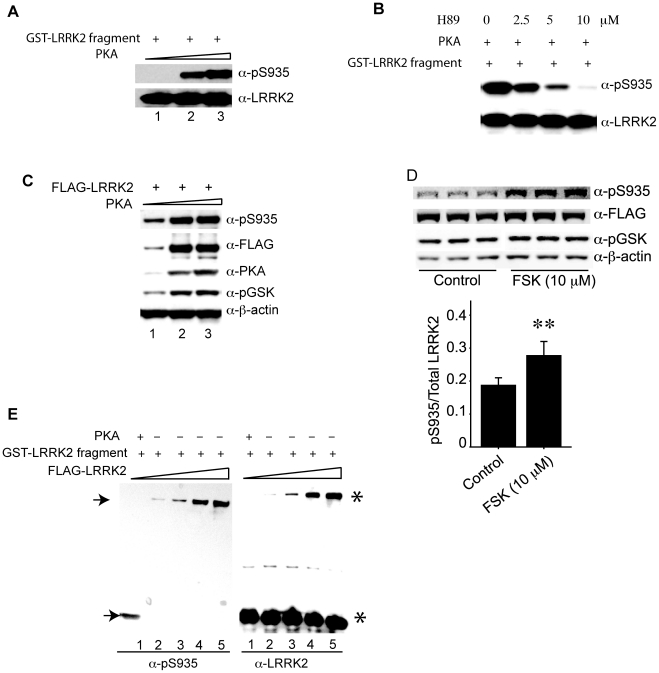
PKA, not LRRK2 itself, can phosphorylate S935 in vitro and within cells.(A) 0.4 µg of purified GST-LRRK2 fragments (800–1000aa) was incubated with different amount of the PKA catalytic subunit (lane 1: without PKA; lane 2: 2500 units PKA; lane 3: 10,000 units PKA). The reaction was stopped by adding 3× SDS-PAGE sample buffer and Western blot was performed by using anti-pS935 and anti-LRRK2 antibodies. (B) Different concentrations of H-89 (0, 2.5, 5 and 10 µM) were added to the PKA and GST-LRRK2 fragment reaction mixture, and Western blot analyses was performed by using anti-pS935 and anti-LRRK2 antibodies. (C) FLAG-LRRK2 was co-transfected with different amounts of PKA plasmid into HEK-293T cells (The ratio of FLAG-LRRK2 verse PKA plasmid DNA are: 0 in lane 1, 1∶1 in lane 2 and 1∶10 in lane 3). The transfected cell lysate was harvested and analyzed by Western blot using anti-pS935, anti-FLAG, anti-PKA, anti-pGSK and anti-β-actin antibodies. (D) FLAG-LRRK2 was transfected into HEK-293T cells and after 40 hours transfection, 10 µM FSK was added to the cell culture medium and incubated for 30 min. Then the cells were harvested and western blot analysis was performed to study various protein levels by using anti-pS935, anti-FLAG, anti-pGSK and anti-β-actin antibodies. The pS935 LRRK2 and total LRRK2 signals were quantified by using the LI-COR Odyssey software system and the ratio of pS935 and total LRRK2 was calculated and analyzed by One-way ANOVA (** P<0.01). Western blot results of three independent experiments are shown, and data are presented as mean value (± SEM) from three independent experiments. (E) GST-LRRK2 fragment (800–1000aa) protein was incubated with purified FLAG-LRRK2 (from mouse brains) or with PKA catalytic enzyme subunit (as positive control) (lane 1: 2500 units PKA; lane 2: 12.5 nM FLAG-LRRK2; lane 3: 25 nM FLAG-LRRK2; lane 4: 125 nM FLAG-LRRK2; lane 5: 250 nM FLAG-LRRK2) in Kinase assay buffer and western blot was performed by using anti-pS935 and anti-LRRK2 antibodies. The arrows indicated the phosphorylated form of full length LRRK2 and GST-LRRK2 fragment; the asterisks indicated the total full length LRRK2 and total GST-LRRK2 fragment, respectively.